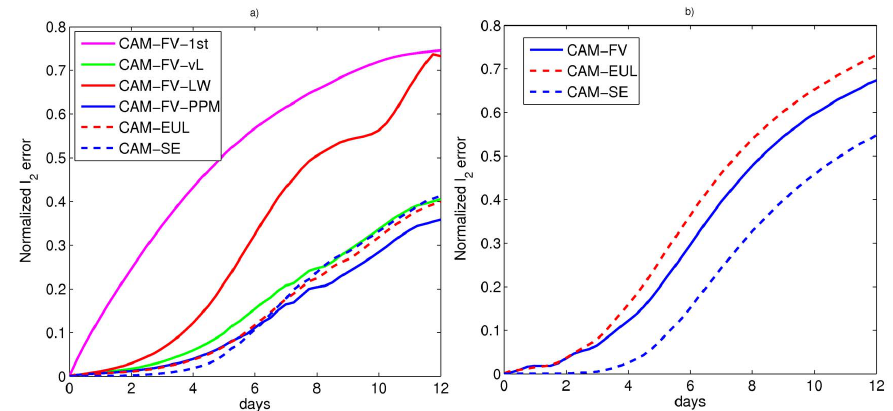
Fig. 9. Normalized l 2 error norms against time for (a) CAM-FV at 2 ◦ × 2 ◦ resolution with the (1st) 1st-order, (vL) van Leer, (LW) Lax– Wendroff, and PPM with the default limiter schemes, CAM-EUL at T85 resolution and CAM-SE for test 1, and for (b) the default versions of CAM-FV, CAM-EUL and CAM-SE for test 2.